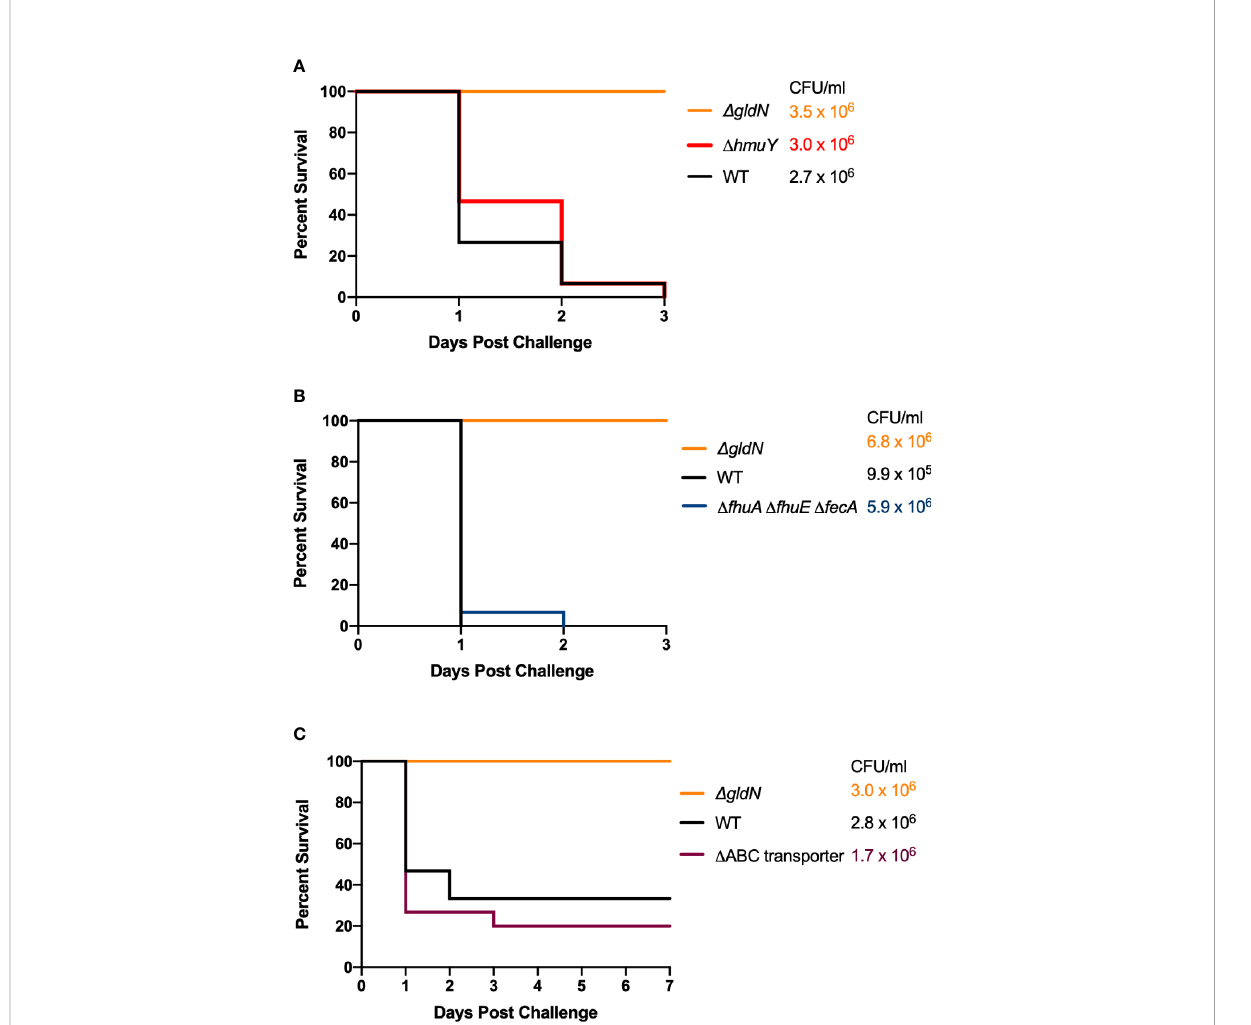
FIGURE 6 Virulence of F. columnare wild type and iron utilization mutants toward adult zebra fi sh. Zebra fi sh were exposed by immersion to F. columnare strains and percent survival was recorded. (A) Wild type (black), D gldN (orange), and D hmuY (red) mutants. The fi nal challenge concentrations for each strain are shown in the corresponding color. (B) Wild type (black), D gldN (orange), and D fhuA D fhuE D fecA (blue), mutants. (C) Wild type (black), D gldN (orange), and D ABC transporter (purple), mutants. The percent survival for fi sh challenged with the wild-type and D hmuY , D fhuA D fhuE D fecA , or D ABC transporter mutant strains were not signi fi cantly